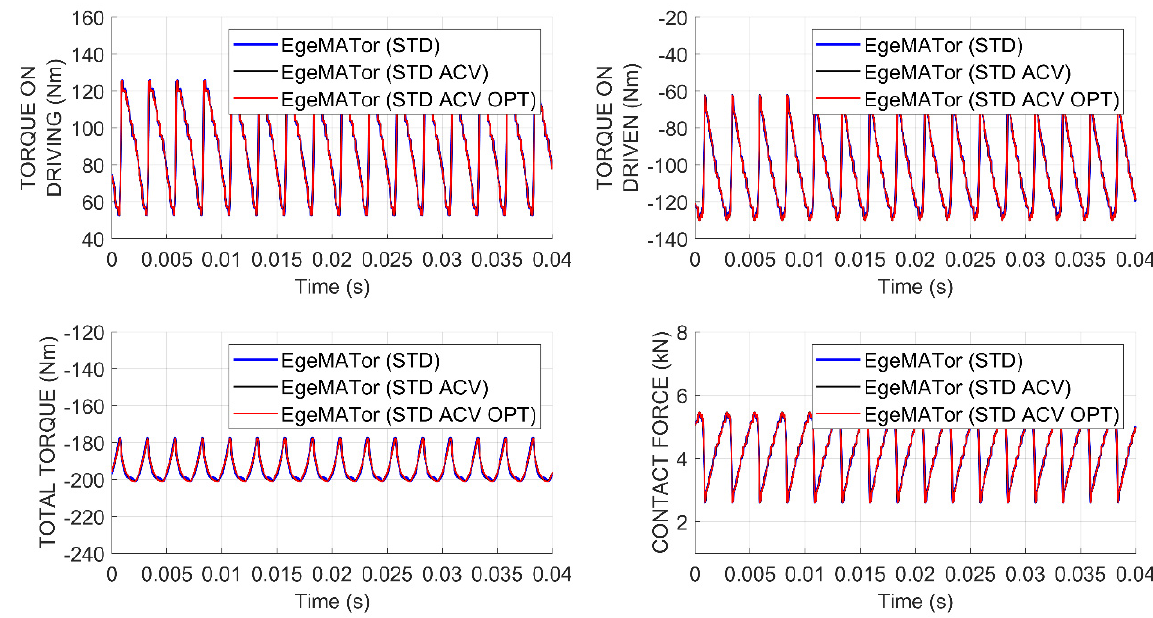
Figure 22. Contact force and numerical torques acting on driving and driven gears.